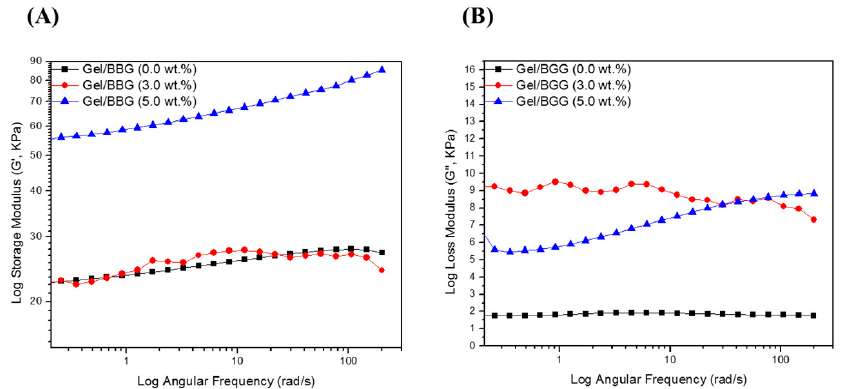
Figure 6. Log scale of ( A ) Storage modulus (G ʹ ) and ( B ) loss modulus (G ʺ ) of the B/BBG nanocom- posite hydrogels as a function of the angular.